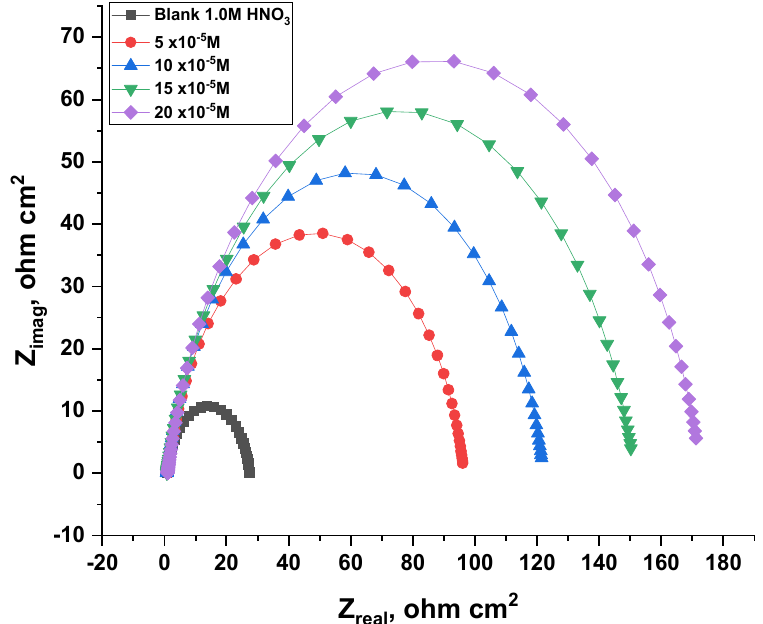
Figure 15. An analysis of the Nyquist plot for copper dissolution in 1.0 M HNO 3 with and without different doses of